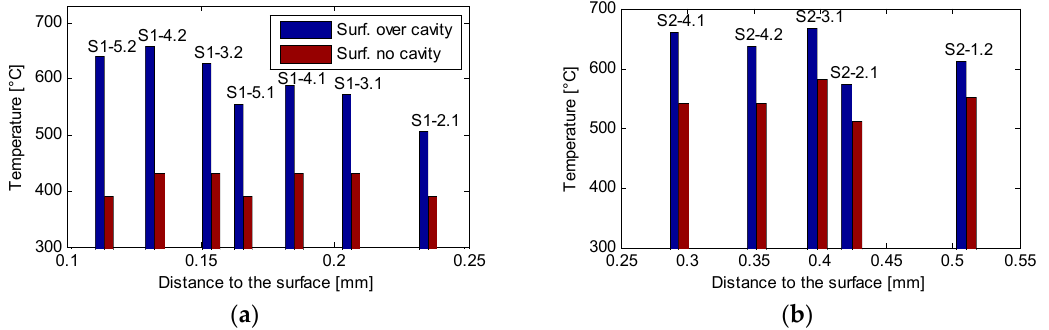
Figure 8. Maximum surface temperatures in condition set S1 ( a ) and in S2 ( b ).